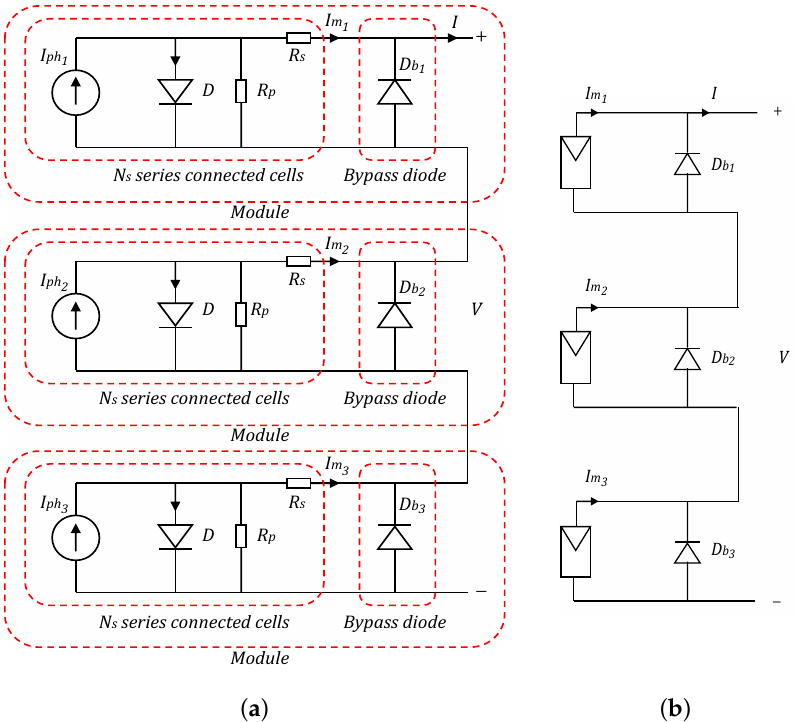
Figure 2. Electrical model of a PV module formed by three submodules by using ( a ) the single diode model and ( b ) a simplified representation of the single diode